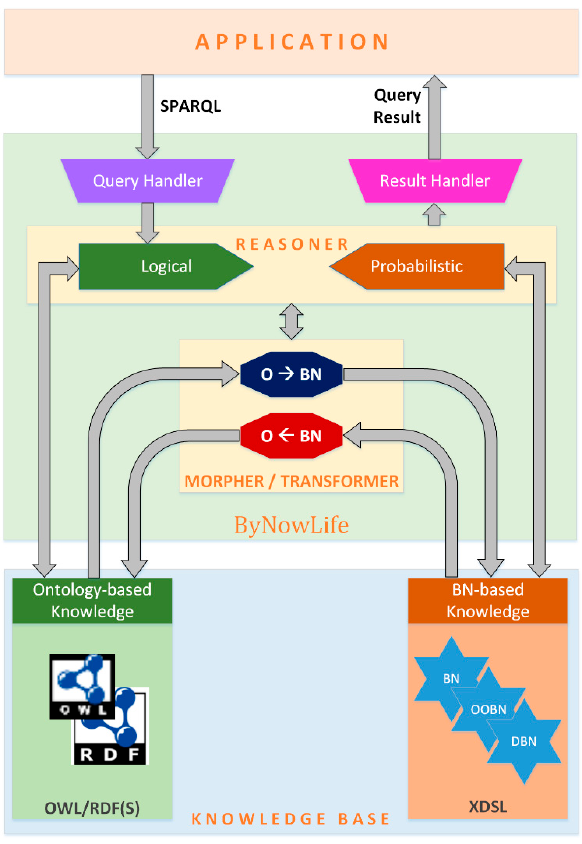
Figure 1. The ByNowLife framework.